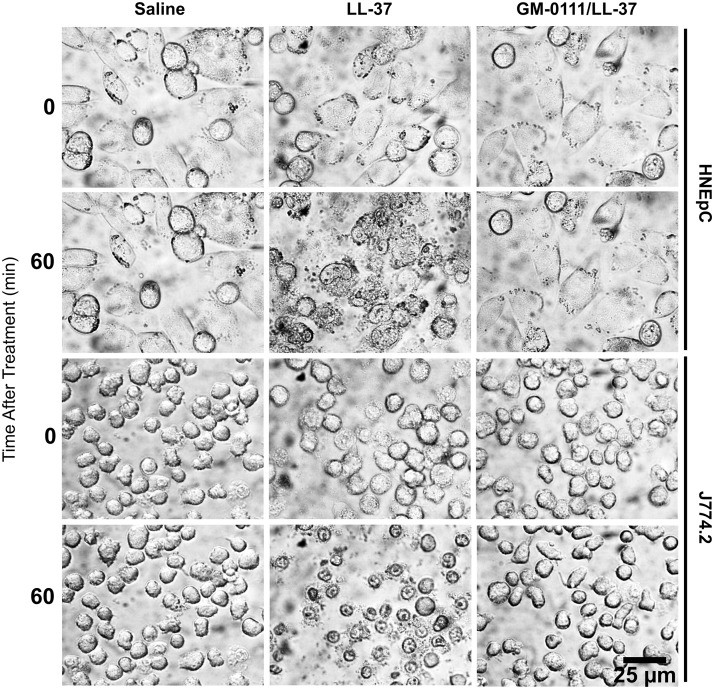
LL-37 induces morphologic change in HNEpCs (upper two rows) and J774.2 cells (bottom two rows), which are prevented with GM-0111 treatment.All images are at 40x magnification.